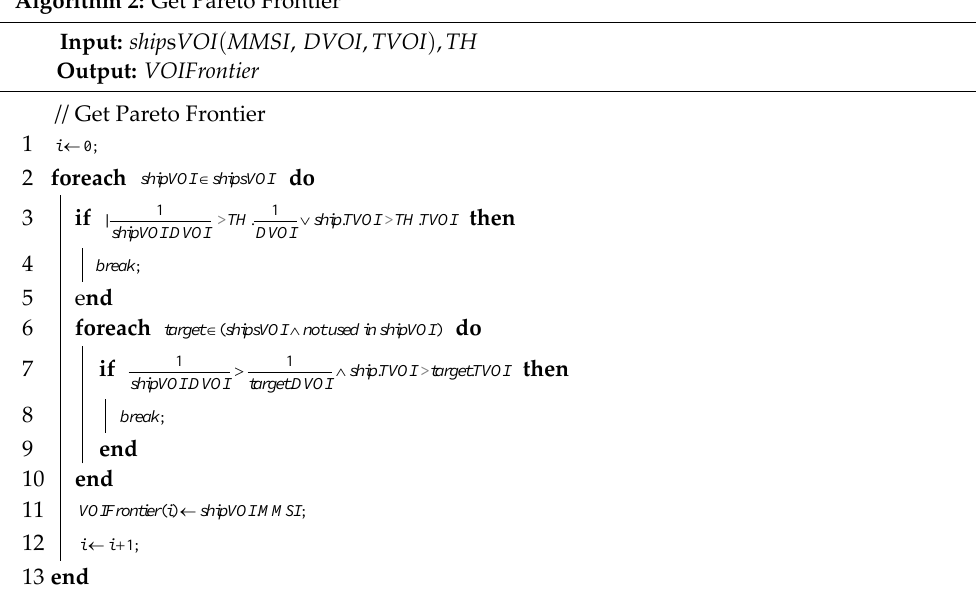
Figure 9. Diagram of the Pareto selection algorithm with a threshold. 3.2. Collision Avoidance Operation Point Screening Based on Piecewise Linear Segmentation To verify the accuracy of the assessment model, the DVOI and TVOI methods are employed to assess the collision risk of AIS data. Specific routes and segments can